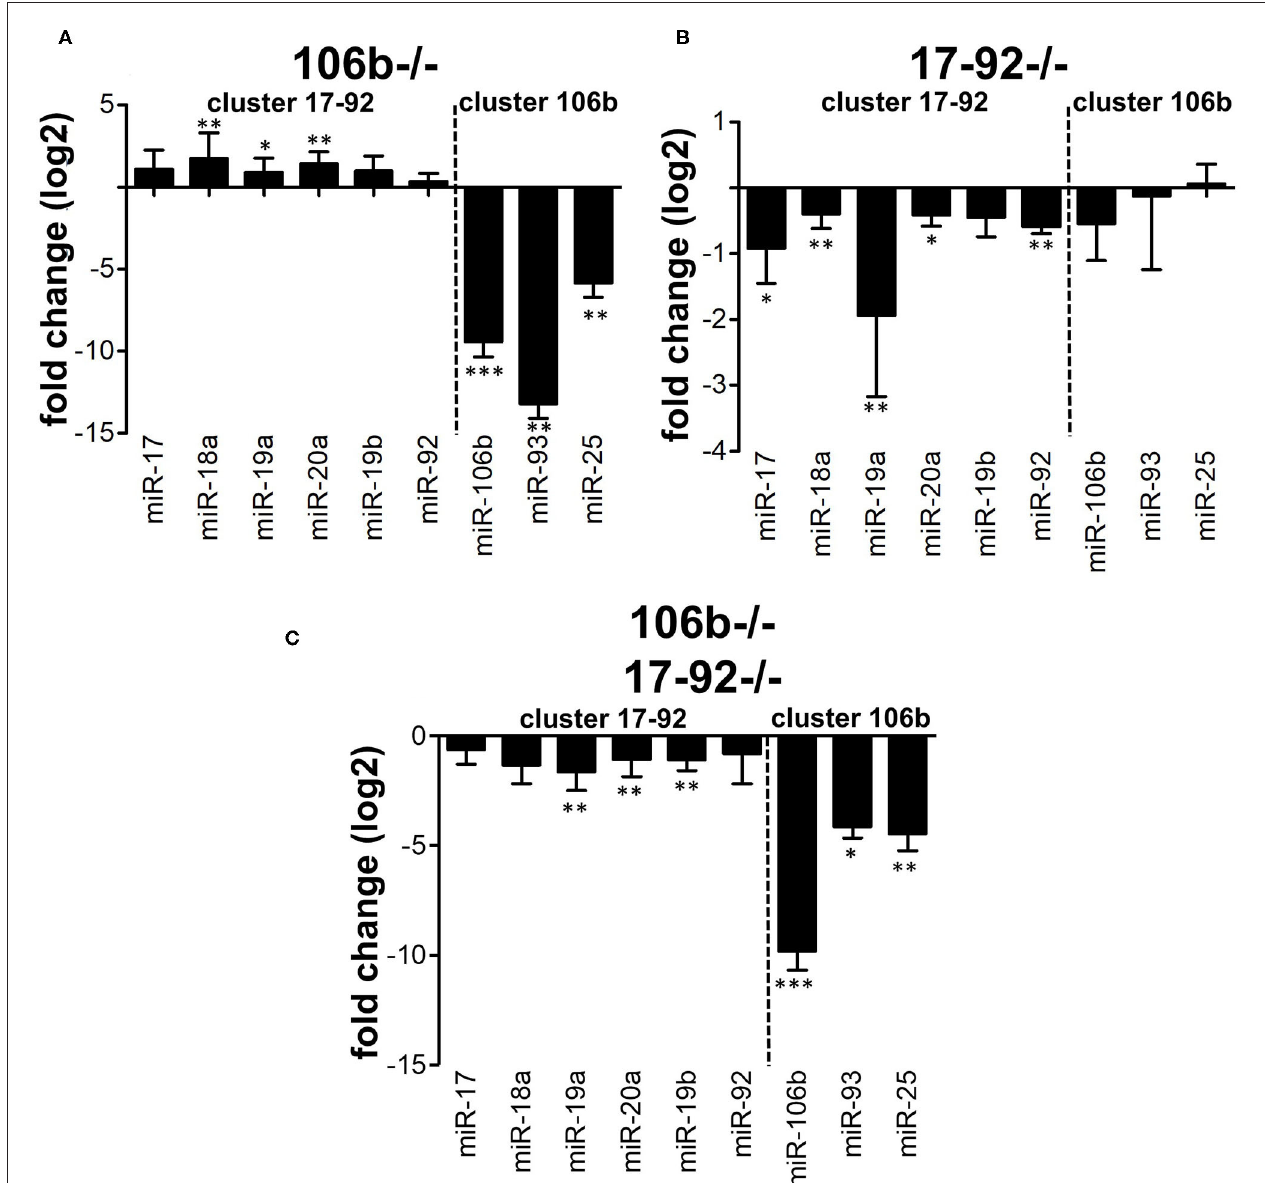
FIGURE 4 | Compensation between miR106b and miR17-92 family clusters. Relative expression (log 2 fold change vs. WT mice) of the 17-92 and 106b family clusters was measured by real time RT-PCR in CD4 + T cells isolated from the spleen of naive 106b − / − (A) , 17-92 − / − (B) , and 106b − / − 17-92 − / − (C) mice. Data are shown as mean ± SEM. miRNA of the two different clusters (miR 106b-25 and miR 17-92 clusters) are divided by a dotted line. * < 0.05; ** < 0.01; *** < 0.001